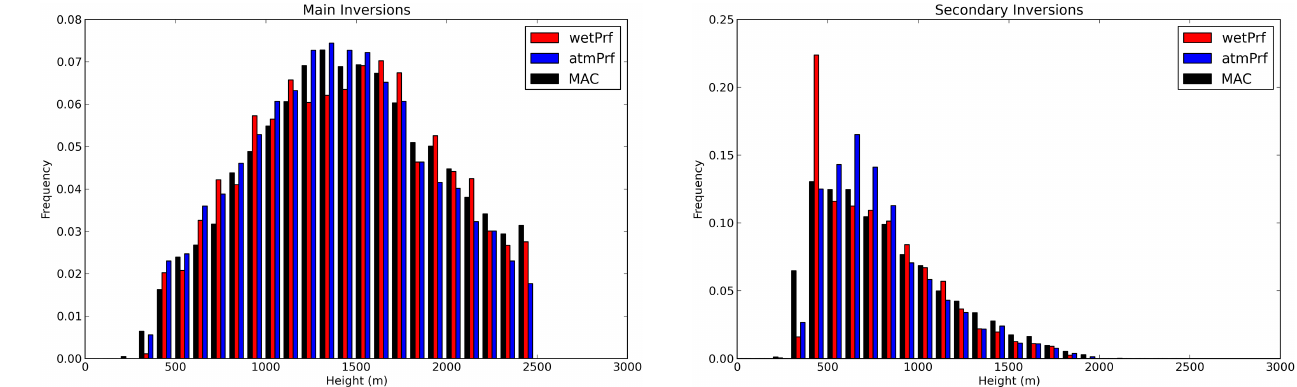
Figure 7. Secondary refractivity break point for MAC (black), COSMIC wet (red), COSMIC raw